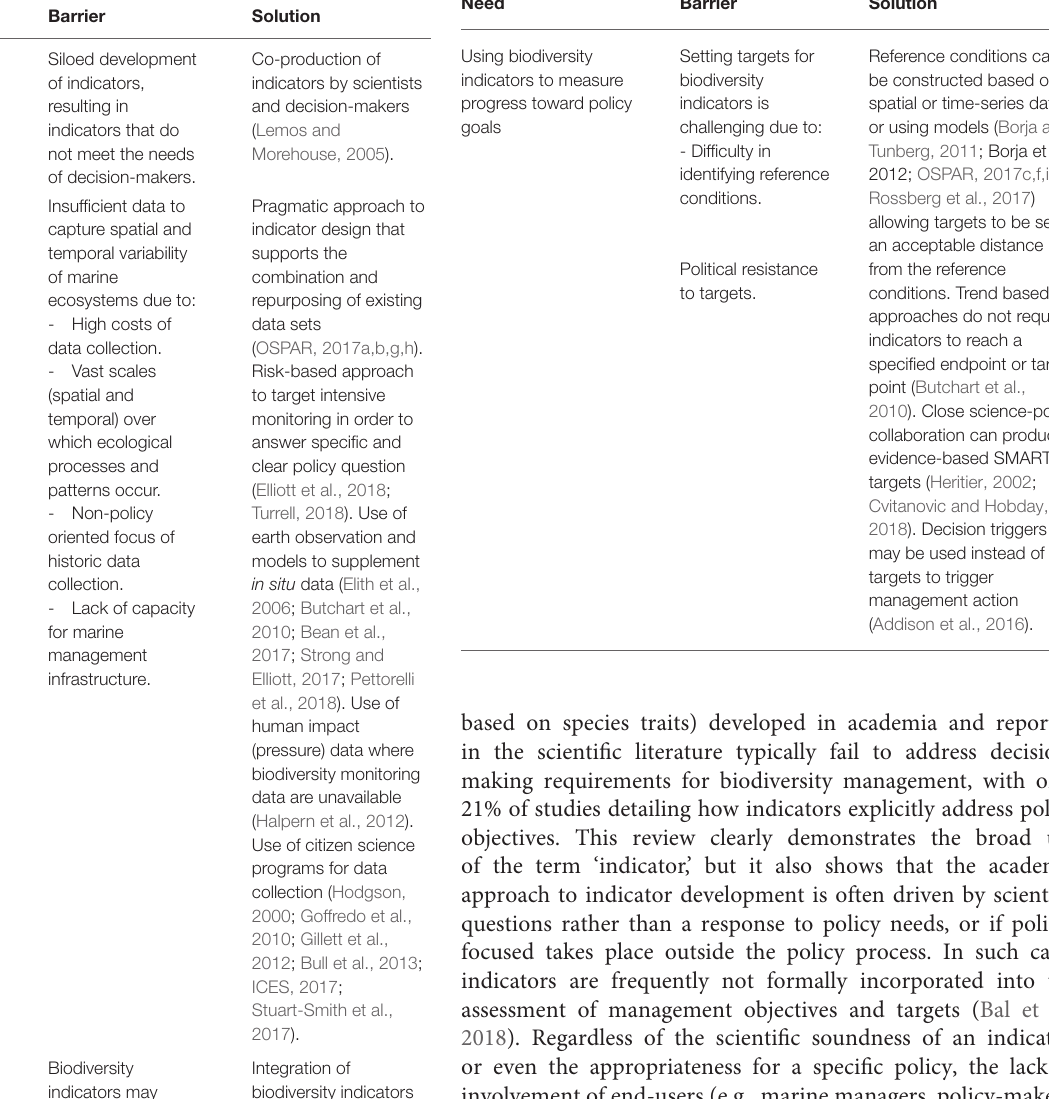
TABLE 2 | Needs, barriers, and solutions to the development and use of marine biodiversity indicators. Need Barrier Solution